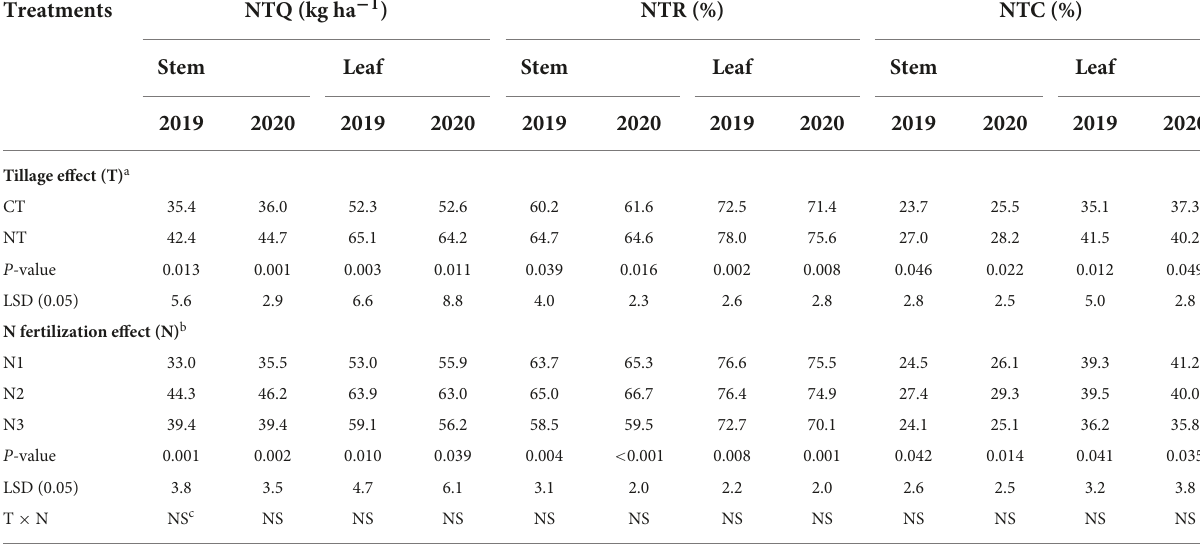
TABLE 4 The quantity of transferred N (NTQ), ratio of transferred N (NTR), and contribution of transferred N to spike (NTC) from stem and leaf as affected by tillage and N fertilization treatments in 2019 and